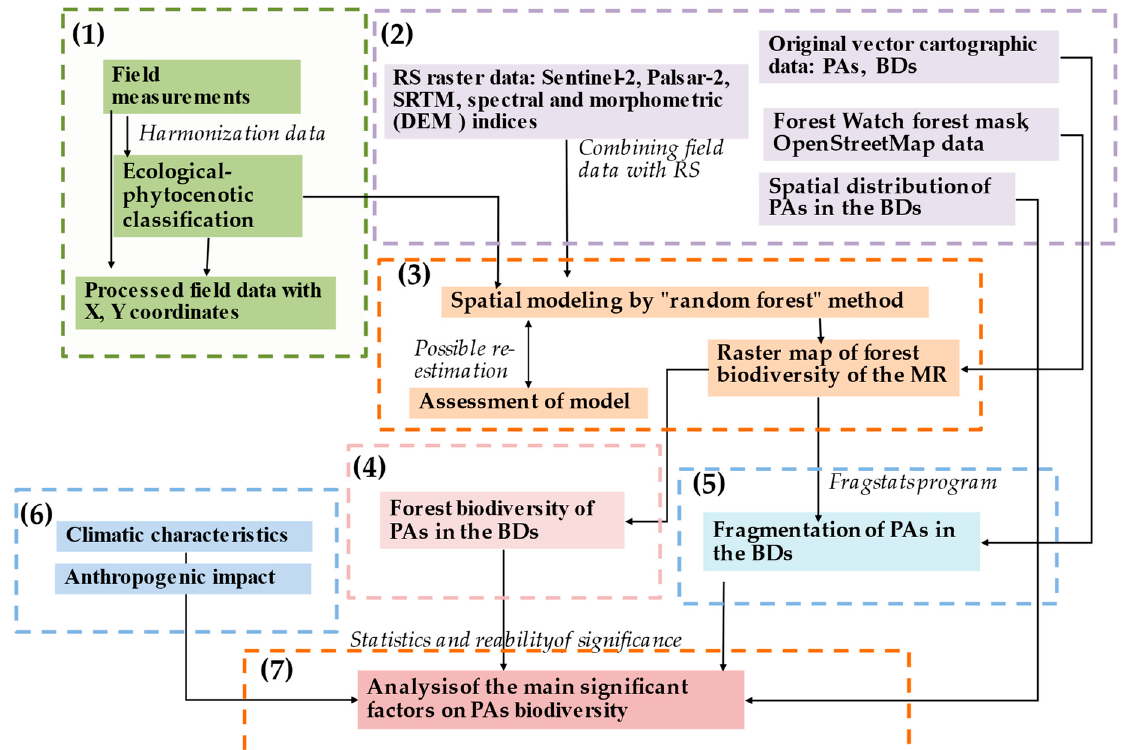
Figure 2. Proposed forest diversity assessment framework for